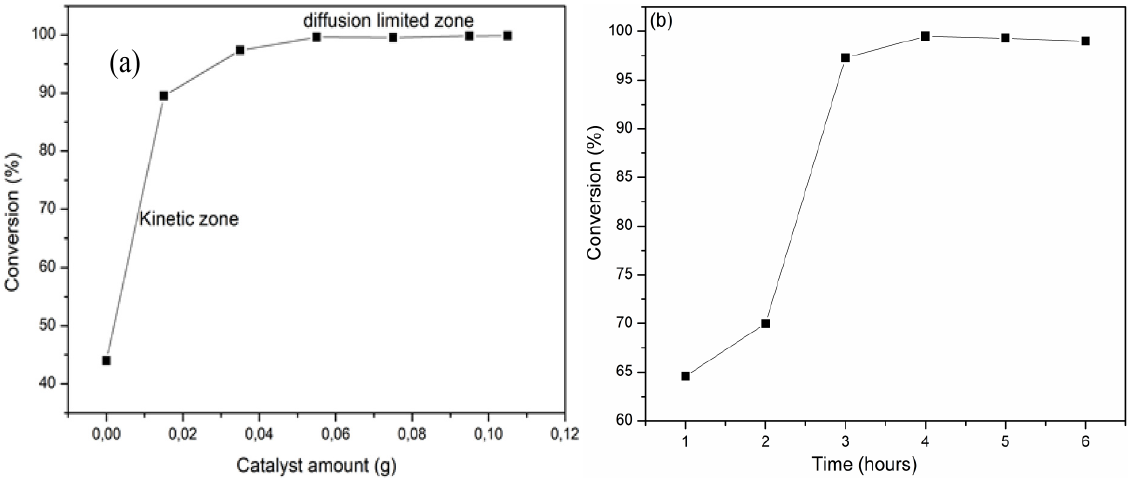
Figure 5. Dependence of furfural percentage conversion on ( a ) catalyst amount and ( b ) reaction time.